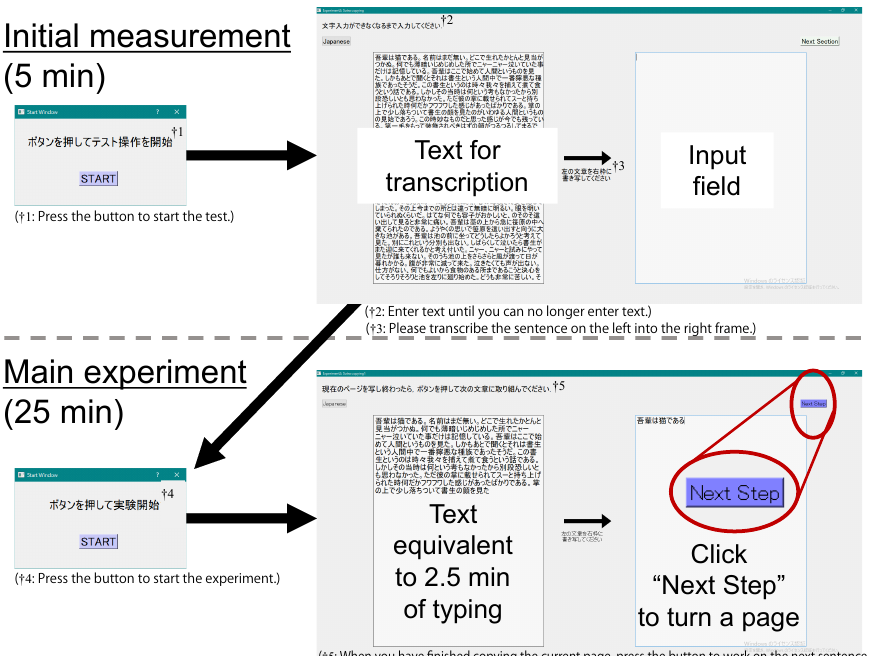
Figure 4. Transcription interface.